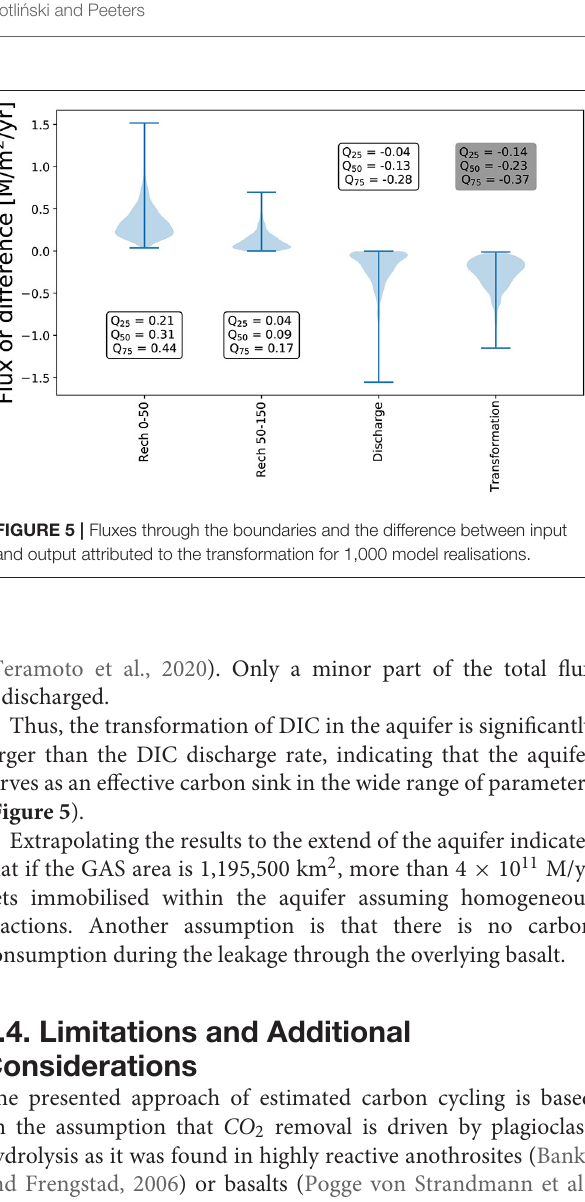
(Teramoto et al., 2020). Only a minor part of the total flux is